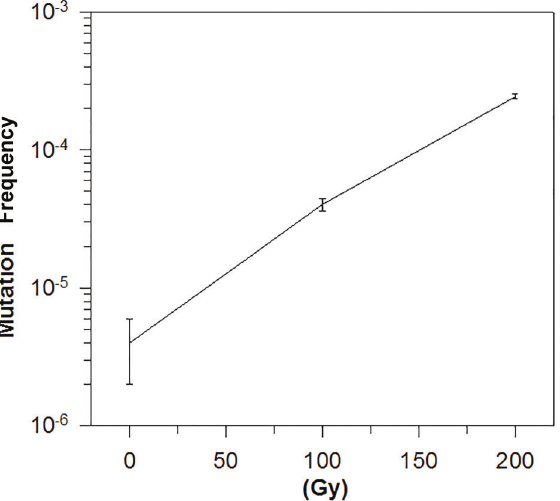
Figure 4 . Mutation frequency of strain SC7K lys2-3 as a function of absorbed gamma ray dose (Gy). Data from at least three repro- ducible experiments are reported as means ± SD.